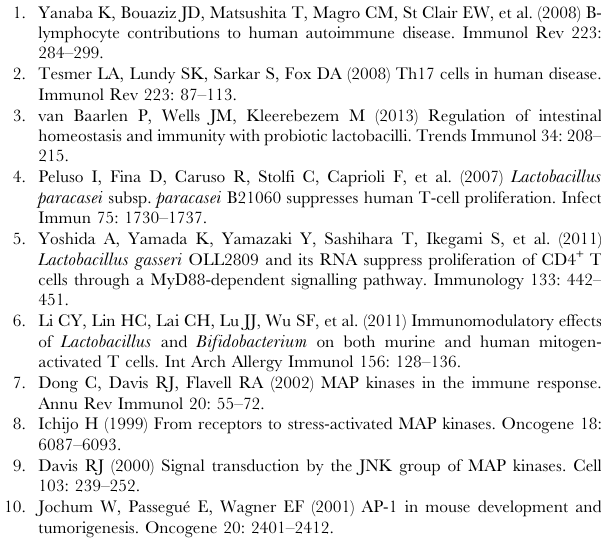
Figure S1 LH2171 suppressed the proliferation of RAW264.7 and Caco-2 cells. RAW264.7 (A) and Caco-2 cells (B) were cultured in the presence or absence of Lactobacillus and